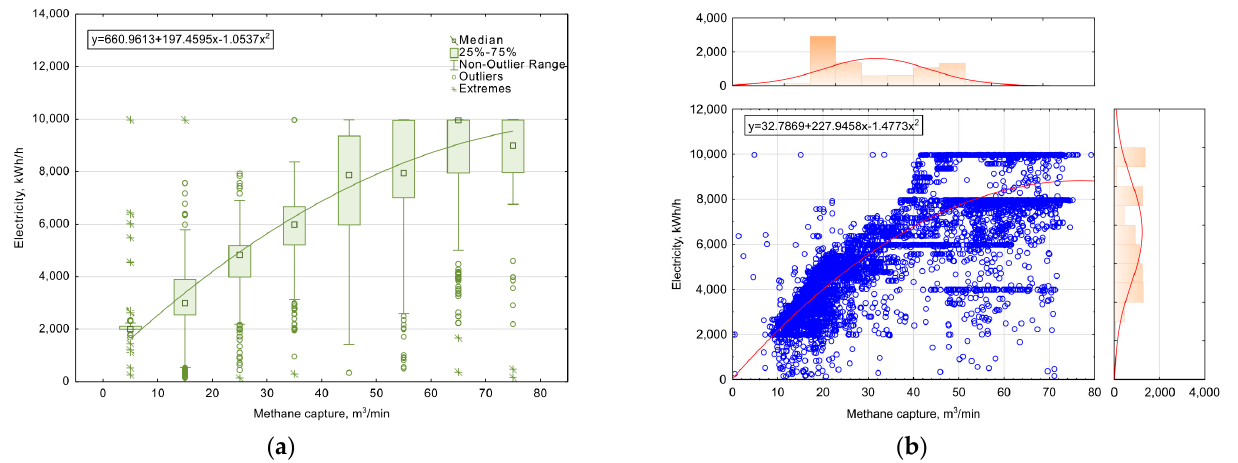
Figure 10. Electricity production as a function of methane capture ( a ) box plot with eight methane capture ranges; ( b ) regression graph with histograms.